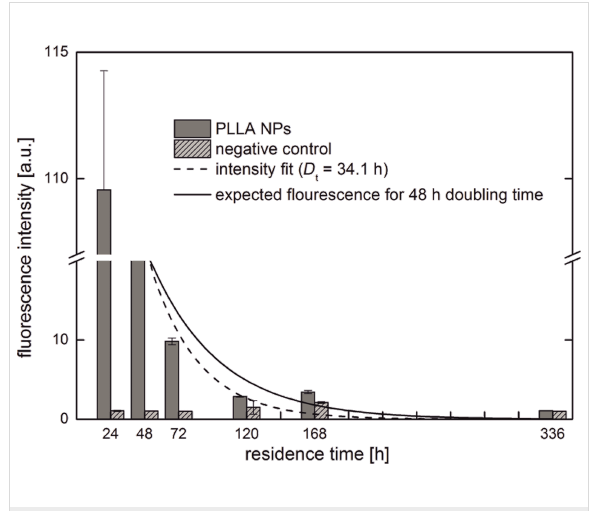
Figure 1: Flow cytometry measurements showing the relative fluores- cence intensity of the cells for different residence